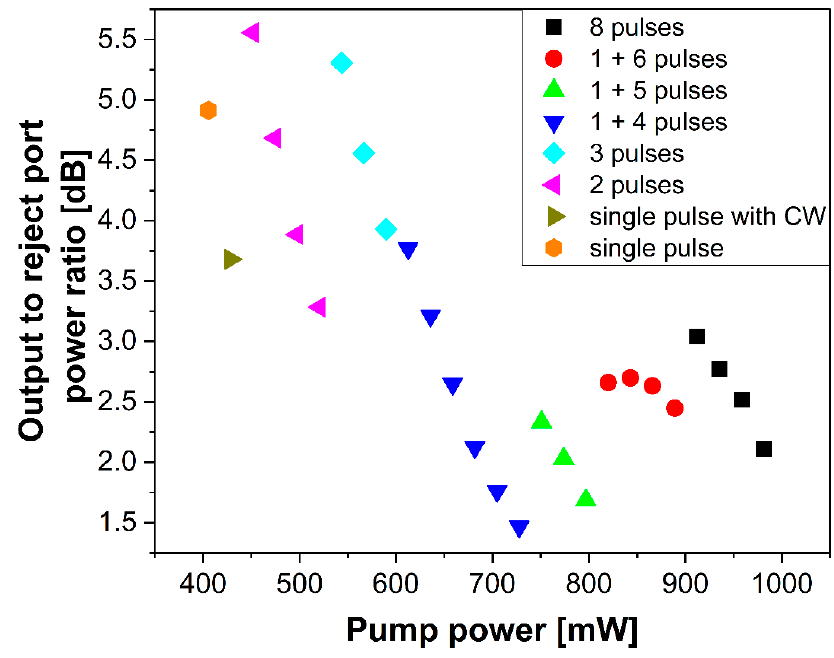
Figure 6. The power ratio between output and reject